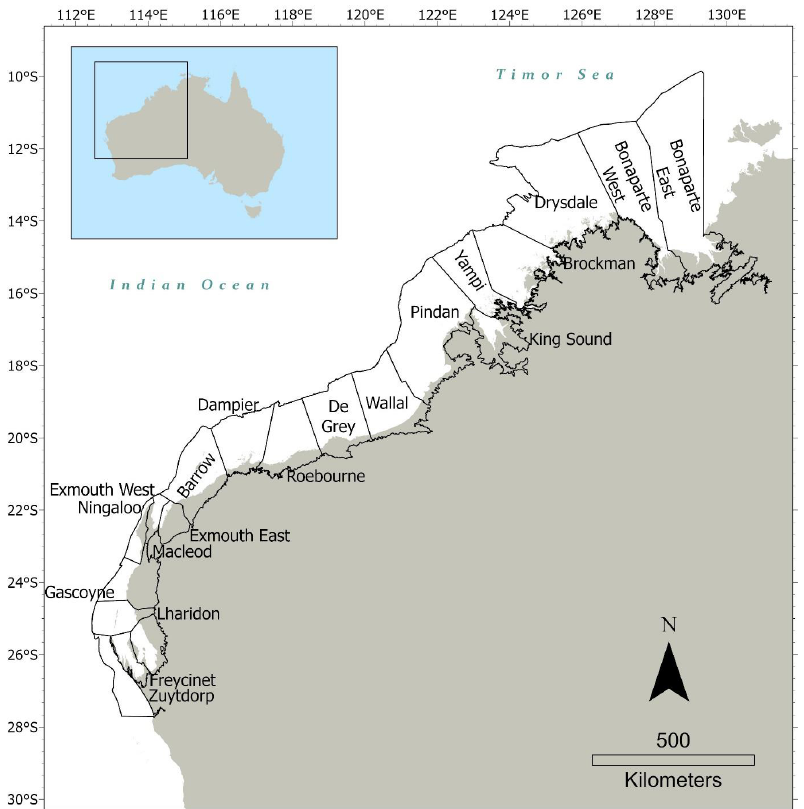
Figure 1. Study region where the mangrove habitat was modelled. Zones (black outline) refer to regions as defined by primary sedimentary processes (source: Geoscience Australia soil layer [22] — see Section 2. Methods). Mangroves occur throughout this geographic extent in North-western Australia, distributed across the coastline in varying densities. Species and density increase with higher latitudes.